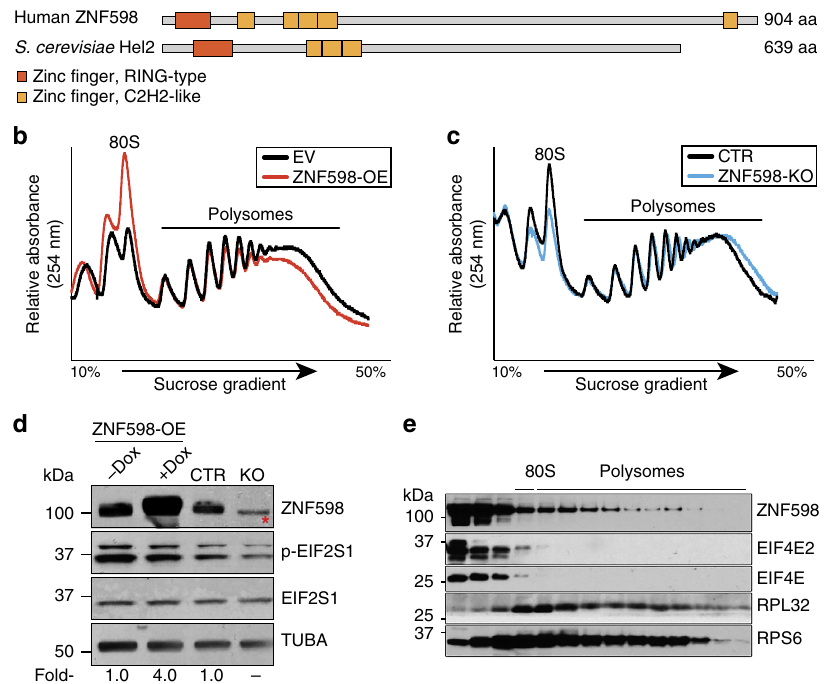
Figure 1 | ZNF598 is a translation repressor that sediments with polysomes. ( a ) Domain organization of the human ZNF598 protein and its yeast orthologue Hel2 as determined by Interpro. The protein length in amino acids (aa) is indicated. ( b ) Polysome profiles of empty vector (EV) and ZNF598-OE HEK293 cells. ( c ) Polysome profiles of parental (CTR) and ZNF598-KO HEK293 cells. ( d ) Western blot analysis of ZNF598 expression and EIF2S1 phosphorylation (p-EIF2S1) to probe for proteotoxic stress in ZNF598-OE and ZNF598-KO cells and controls. * Indicates a non-specific band recognized by the anti-ZNF598 antibody (GeneTex). Numbers indicate the ratio of ZNF598 expression relative to CTR cells. ( e ) Western blot analysis with the indicated antibodies of fractions of the ZNF598-OE HEK293 cell lysates after separation over a 10–50% sucrose gradient. The position of 80S ribosomes and polysomes in the gradient is